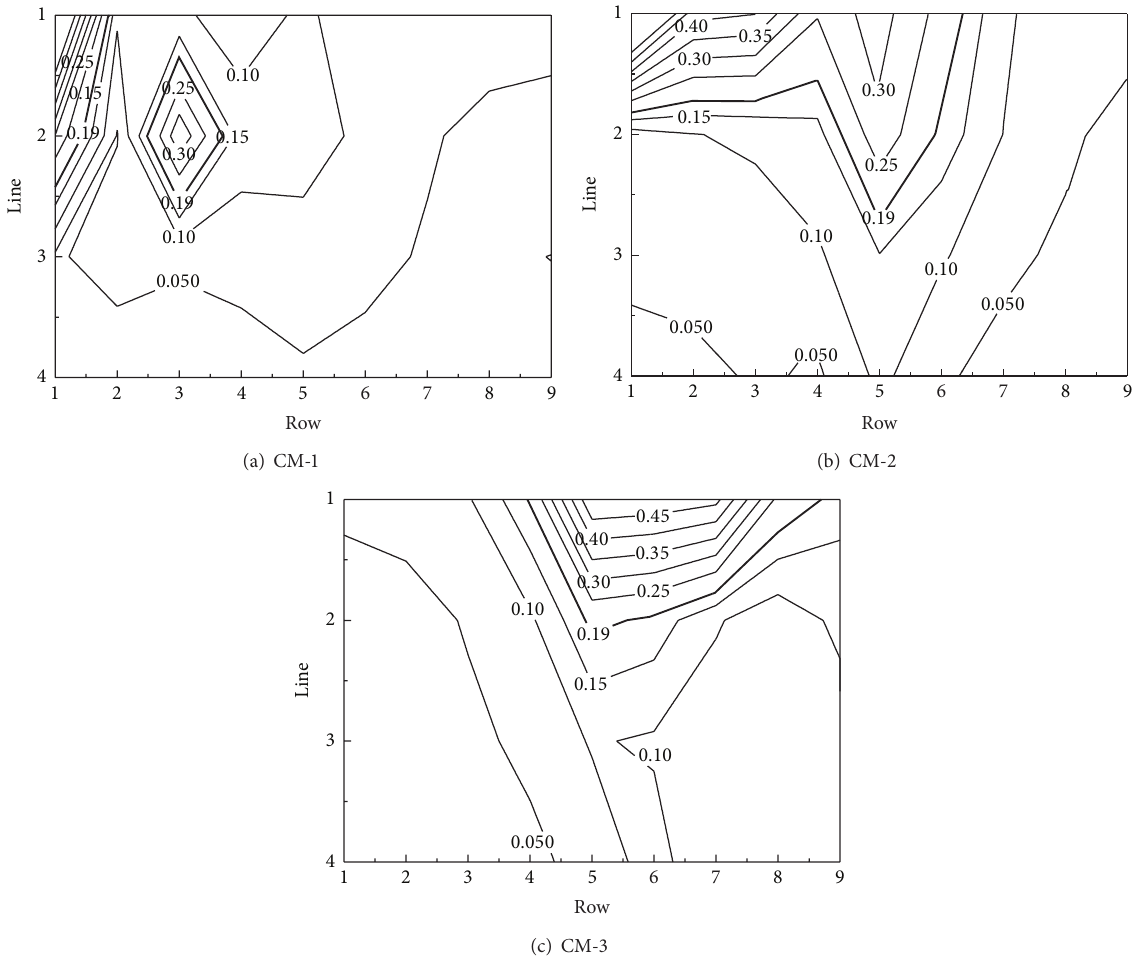
Figure 4: Blast-induced damage zone in